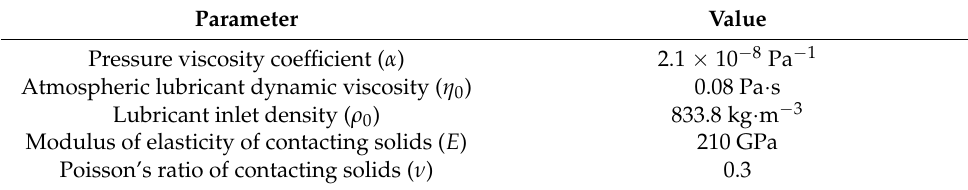
Table 2. Lubricant and Material